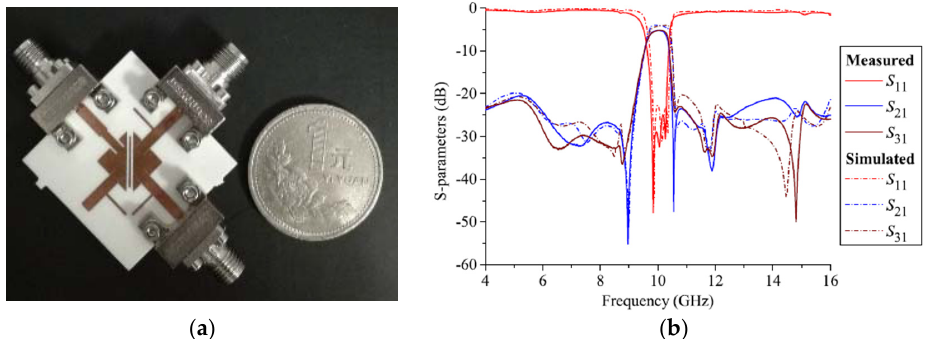
Figure 5. The proposed microstrip balun BPF [45]: ( a ) Photograph of the prototype; ( b ) S-parameter performance.